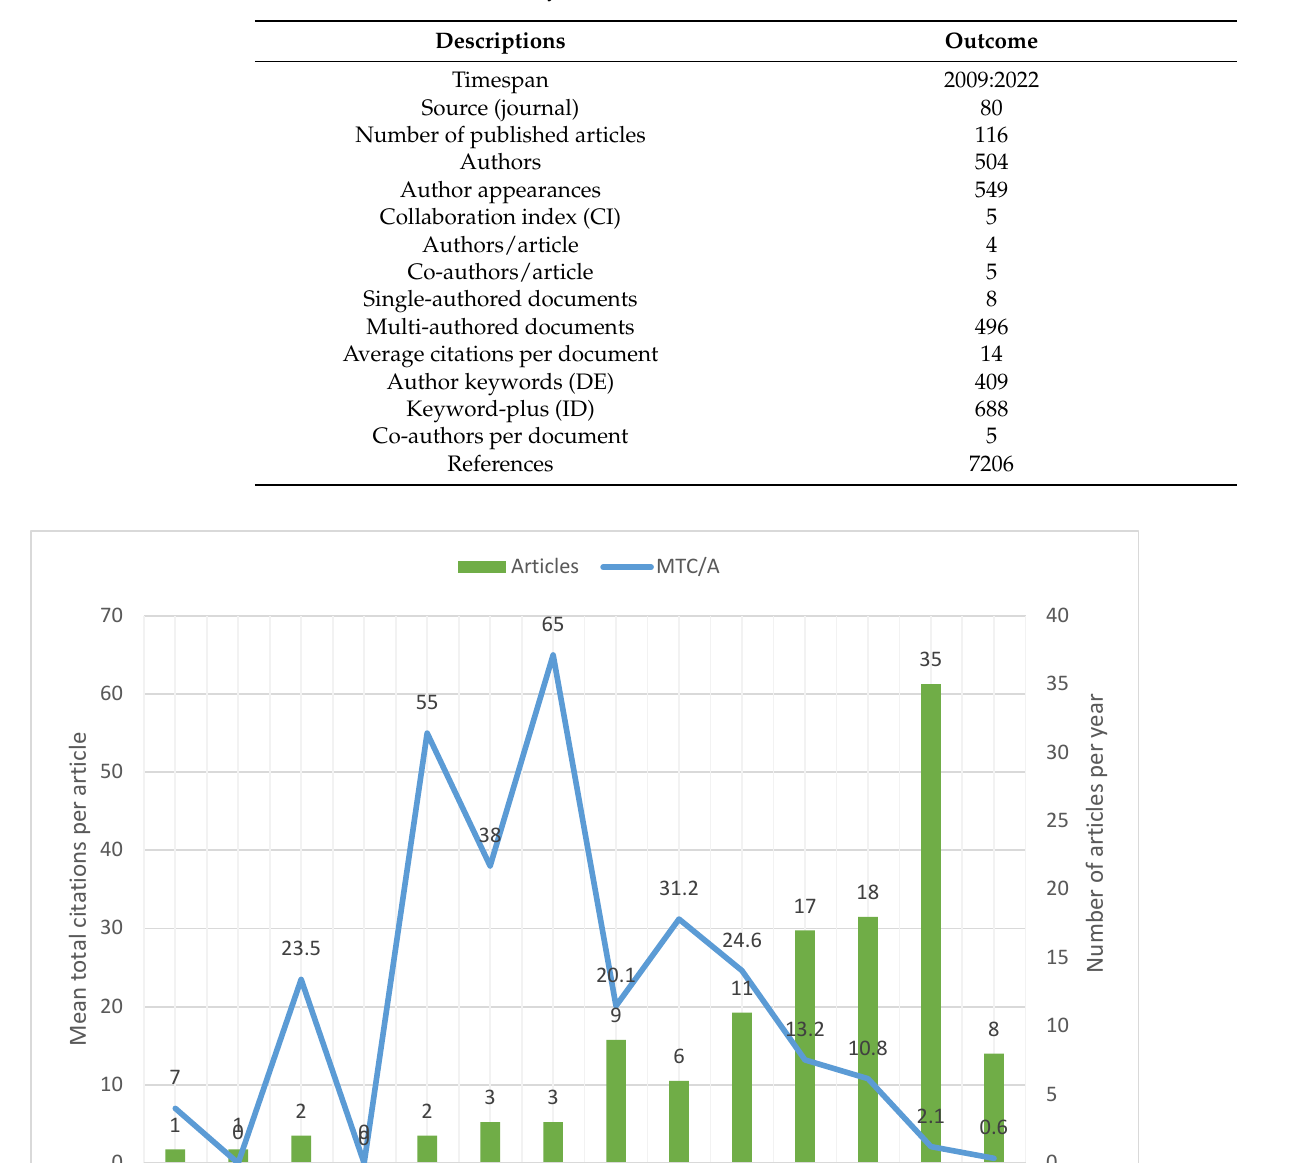
Table 3. Information summary on retrieved CSA-CCAP studies (2009–2022).